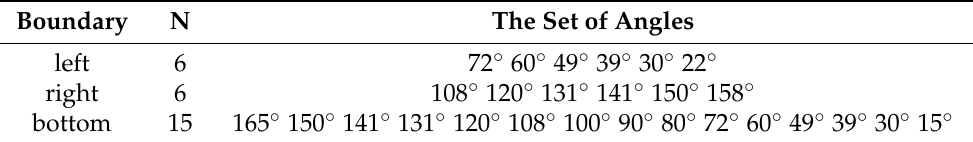
Table 1. The angel setting of anchor lines.